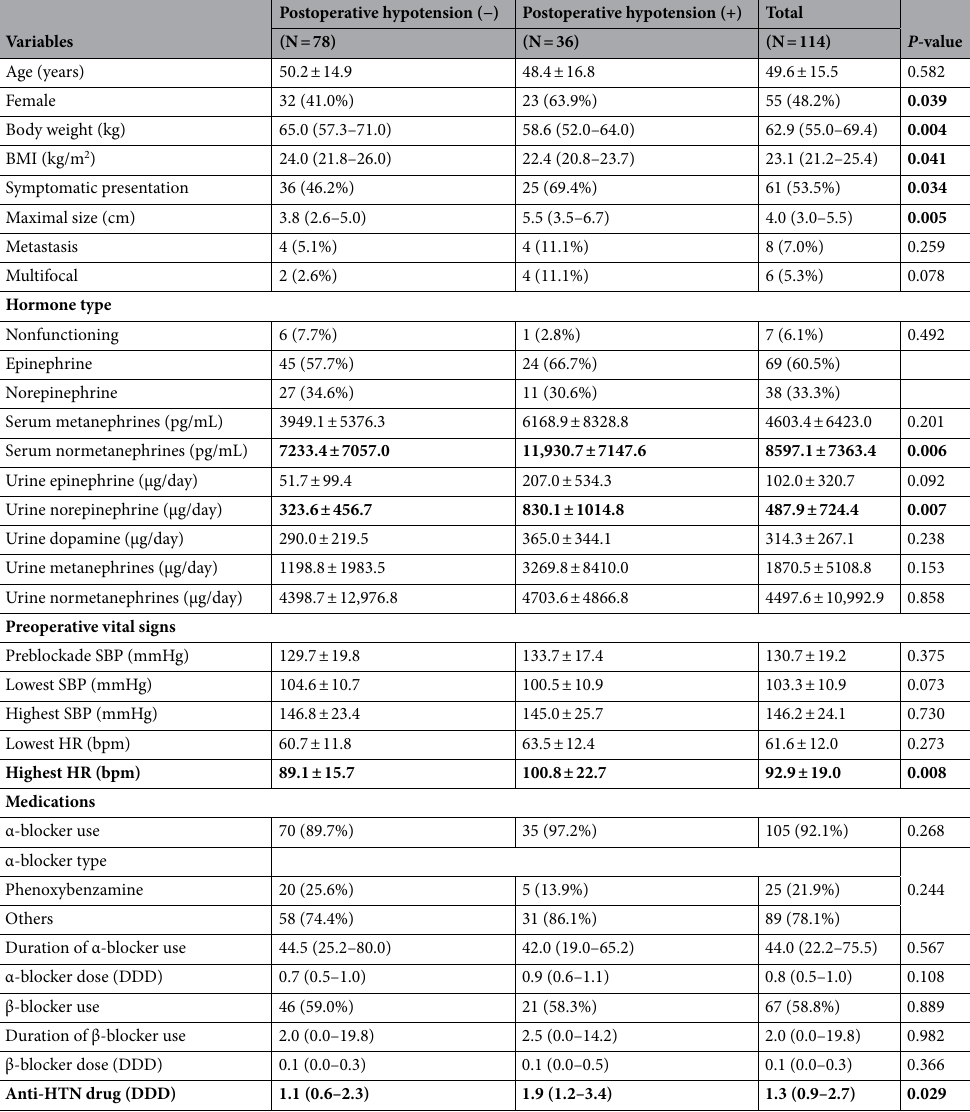
Table 5. Clinical predictors for postoperative hypotension in PPGL patients.